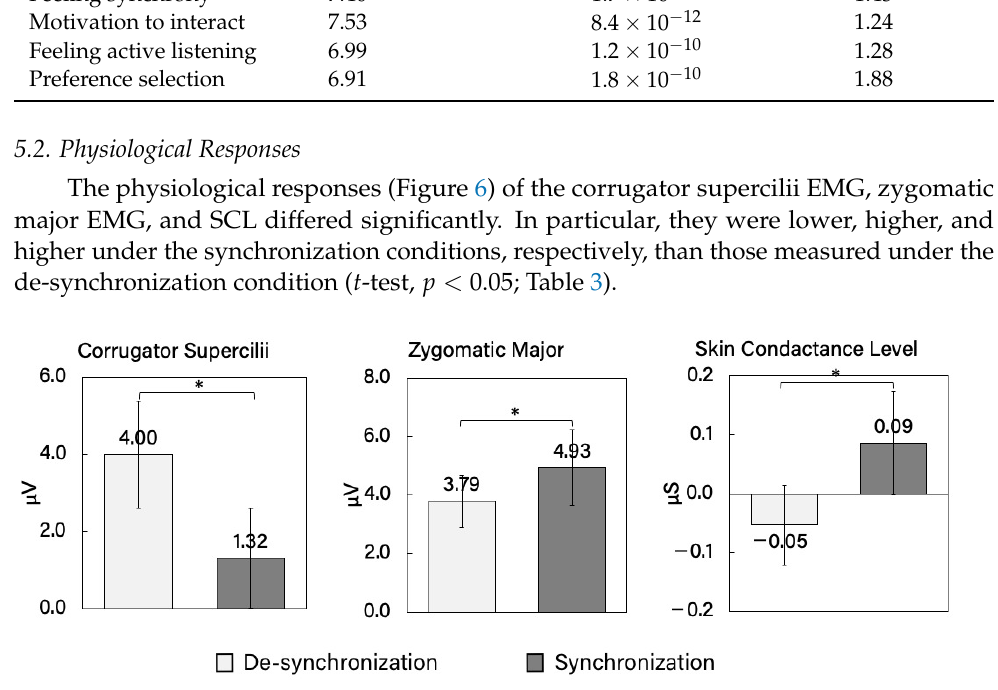
Figure 6. Means with standard error of the facial electromyography from the corrugator supercilii (left image), zygomatic major muscles (middle image), and skin conductance level (right image); * p < 0.05. Table 3. Results of one-sample t -tests for the intra-individual correlation coefficients of the expected subjective physiological concordance across the